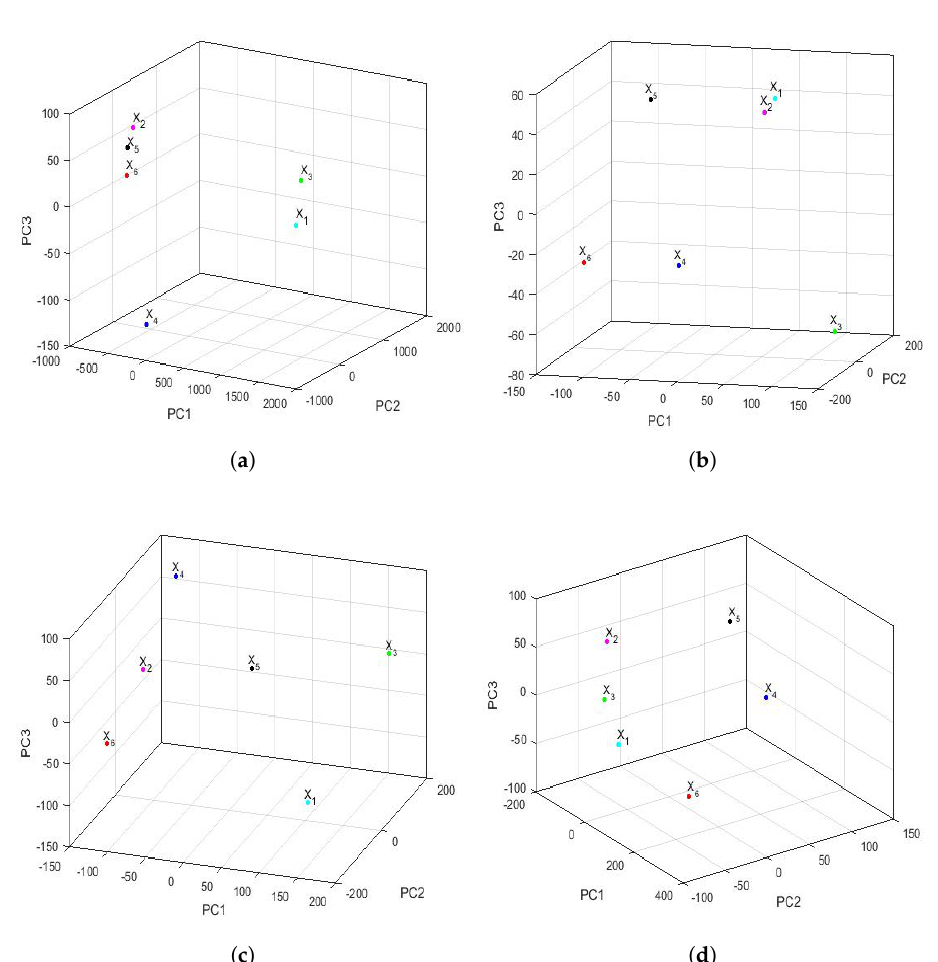
Figure 20. First three principal components of the feature vectors by trimesters of each of the years of the 2015–2020 six-year term: X 1 (2015), . . ., X 6 (2020). ( a ) Feature vectors: first 3 principal components of the first trimester. ( b ) Feature vectors: first 3 principal components of the second trimester. ( c ) Feature vectors: first 3 principal components of the third trimester. ( d ) Feature vectors: first 3 principal components of the fourth